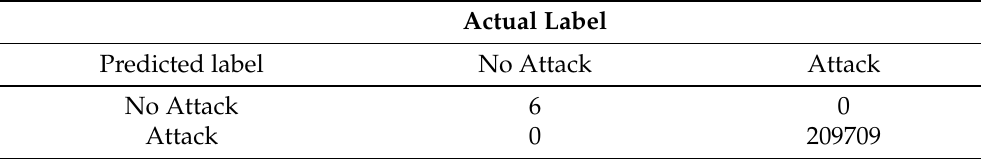
Table 16. DDoS TCP RF confusion